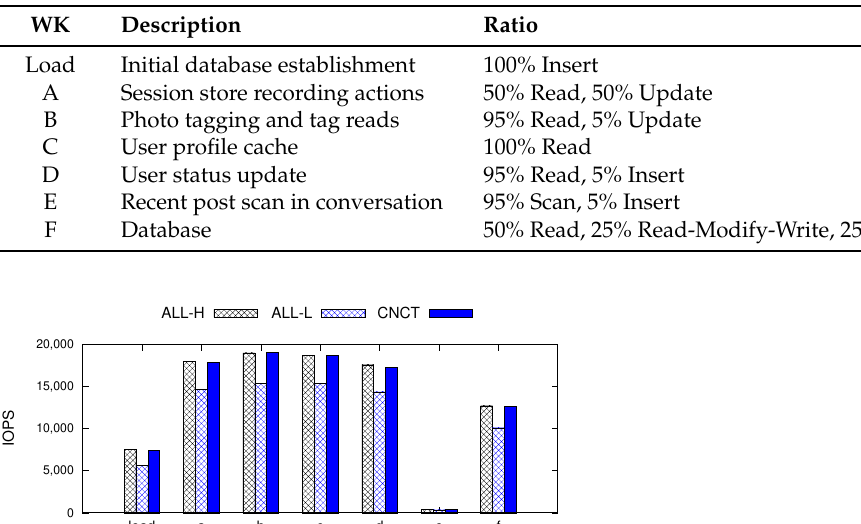
Table 3. YCSB workload characteristics.